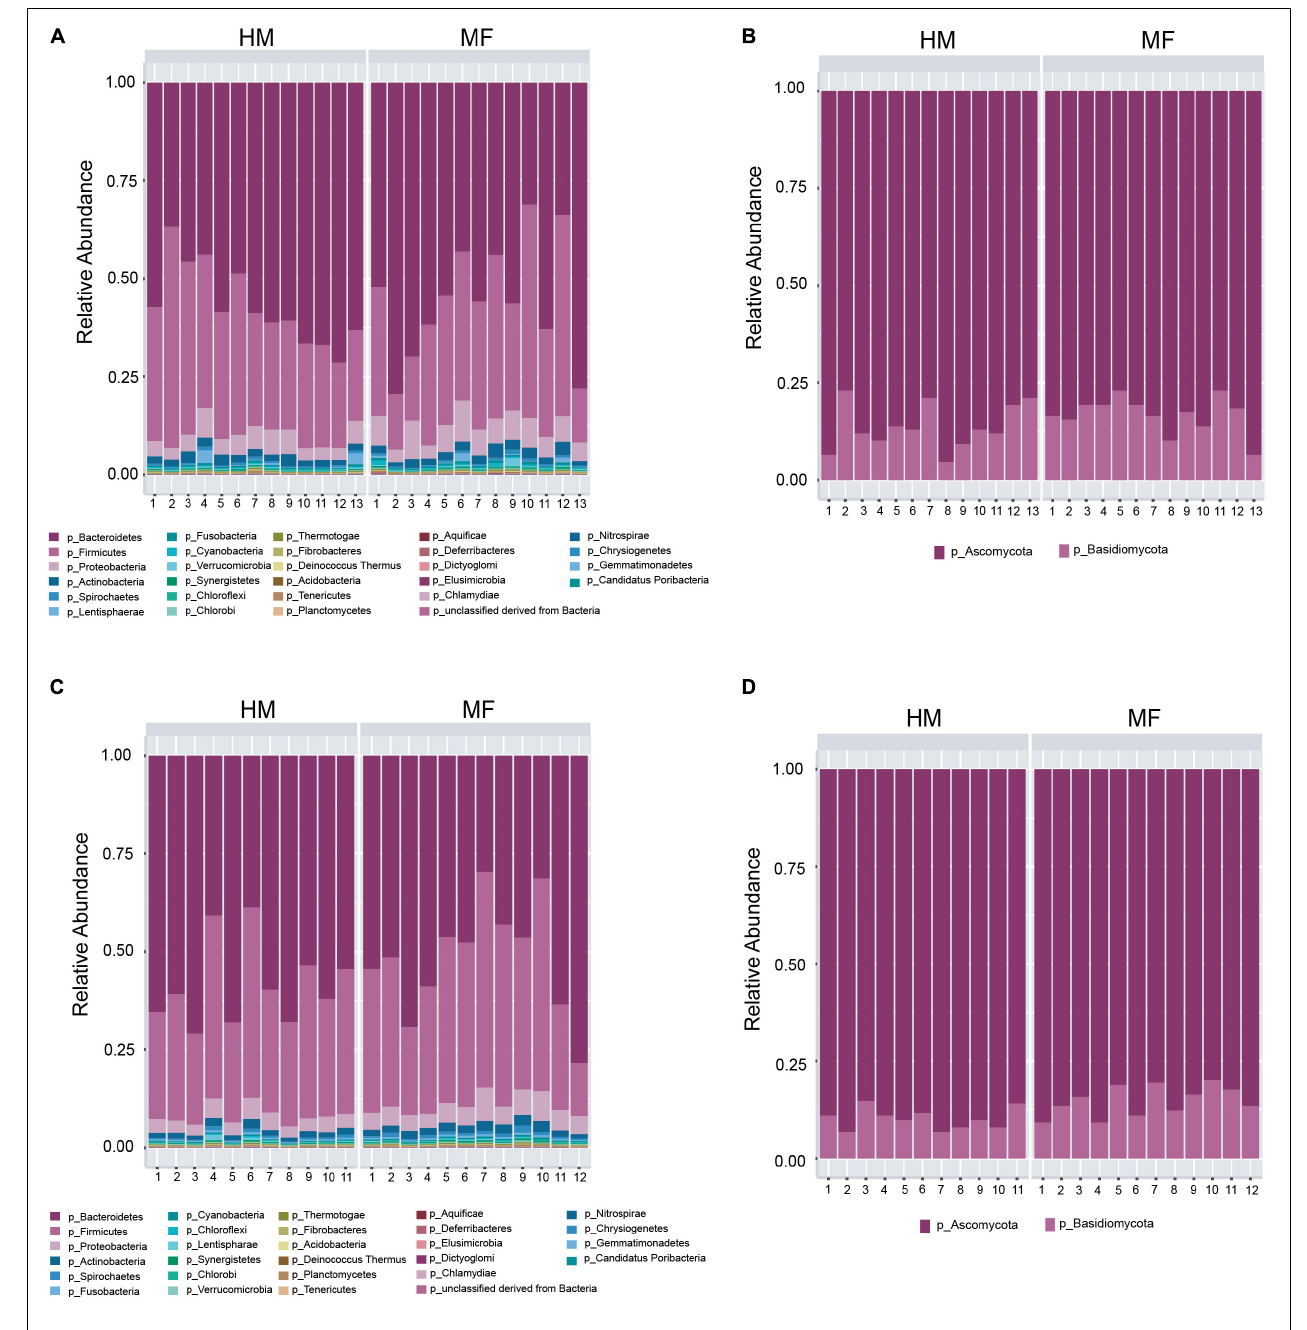
FIGURE 4 | Taxonomic composition at phyla level at postnatal day 51 (PND 51) in male piglets HM or MF from day 2 until day 21 of age. (A) Cecal bacteria; (B) cecal fungi; (C) distal colon bacteria; (D) distal colon